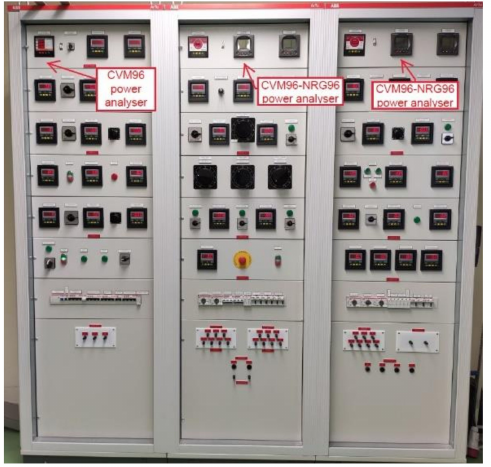
Figure 8. Electrical panel located in the electrical machine